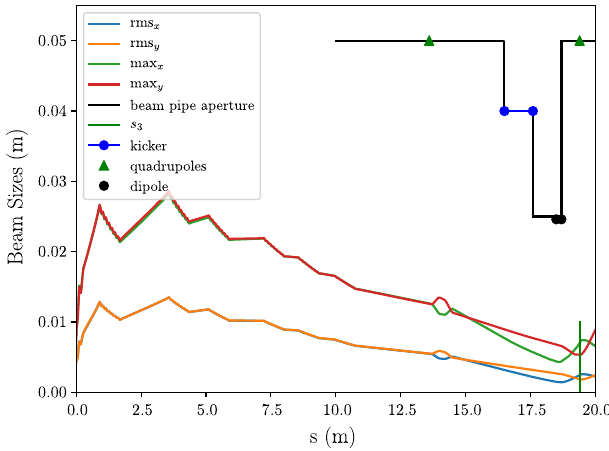
FIG. 10. Optimized beam sizes along high charge beam line. The gun is located at s ¼ 0 , both x and y beam sizes are shown. The black line represents the relevant beam line aperture, while the vertical green line indicates the location of the optimization.